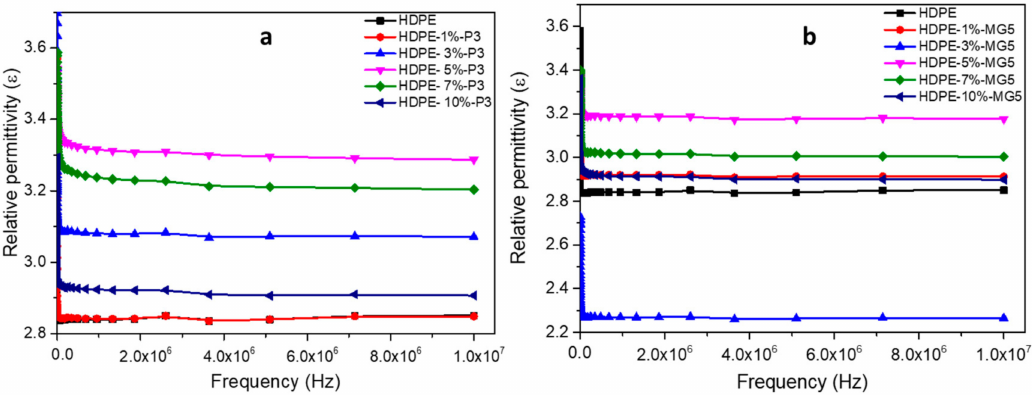
Figure 12. Relative permittivity–frequency relationship of ( a ) HDPE-P3 and ( b ) HDPE-MG5 composites.